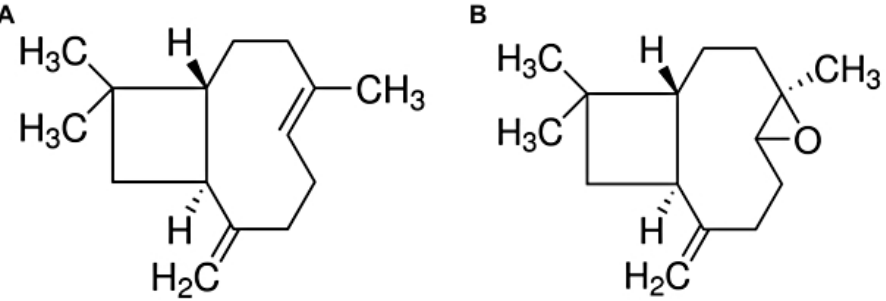
Figure 1. Chemical structures of β -caryophyllene (CAR) ( A ) and caryophyllene oxide (OX) ( B ).